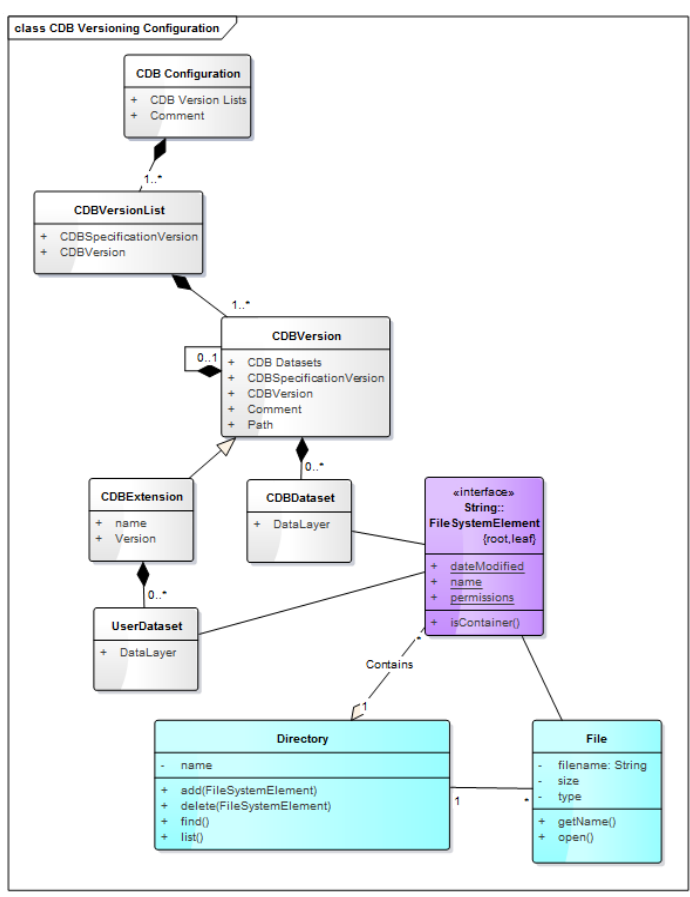
Figure 9. UML diagram of the CDB version concept.